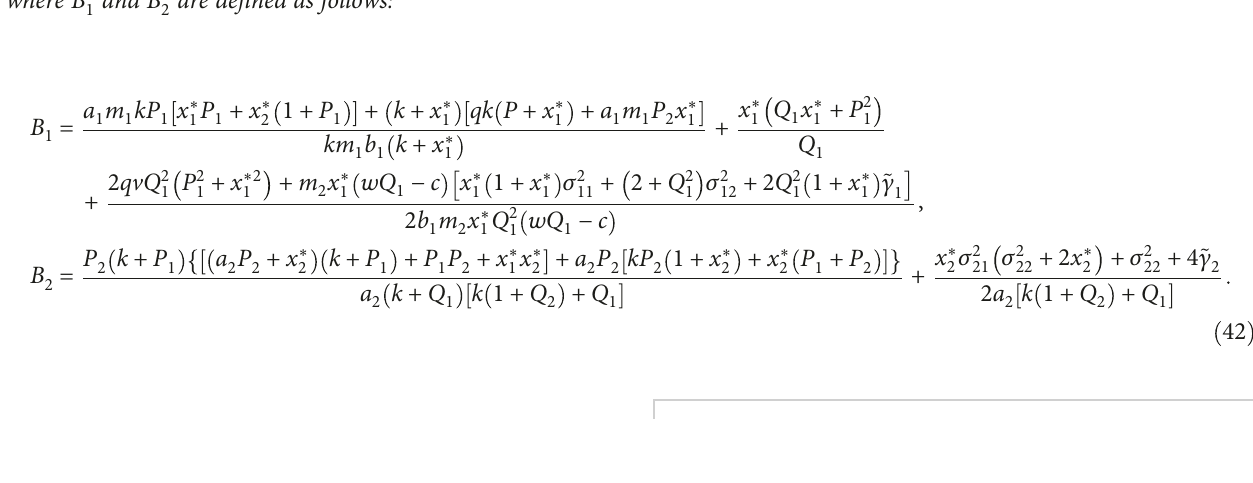
= 2 , b = 0 4 , a = 0 5 , k = 6 , q = 0 1 , m 1 1 1 u = 0 i = 1, 2 , dynamical responses of system (21) are plotted, where (a) τ 1 = 0 75 , τ 2 = 2 92 , and system (21) i